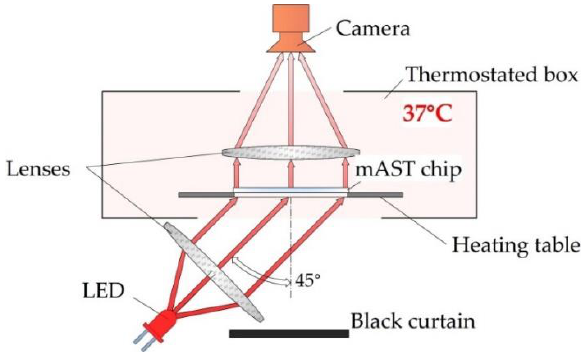
Figure 4. Schematic depiction of the detection setup.